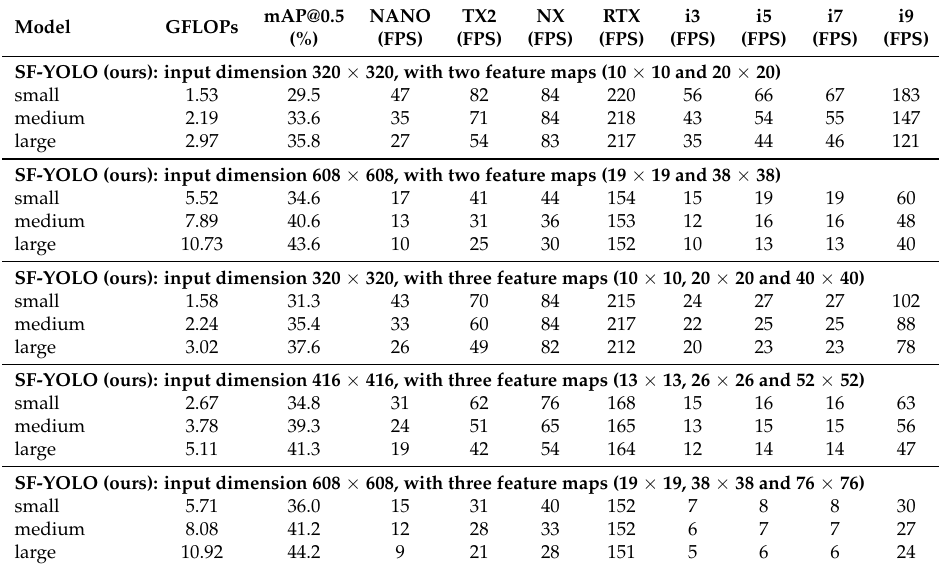
Table 5. Comparison between various condition of